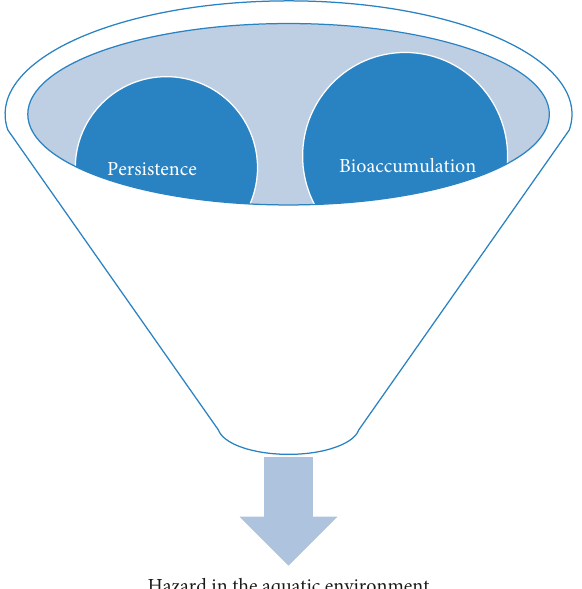
Figure 2: Hazard of a substance in the aquatic environment is a function of its persistence, bioaccumulation, and toxicity